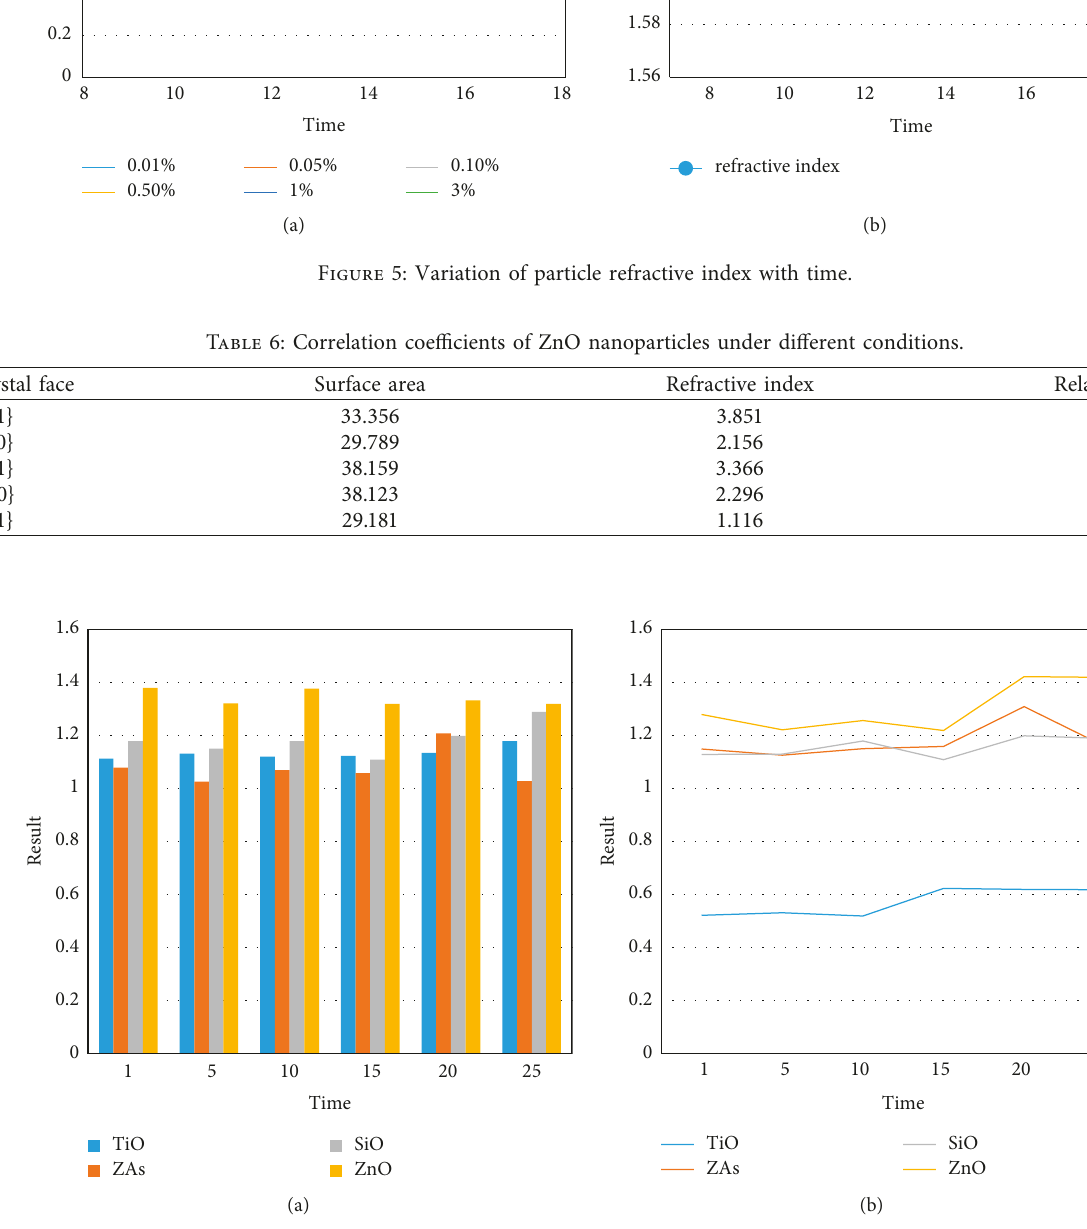
Figure 6: Activity and flexibility tests of different